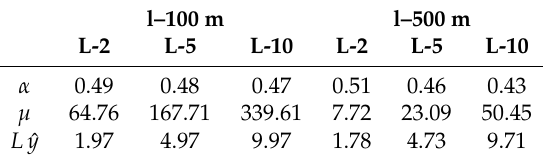
Table 2. α − µ distribution